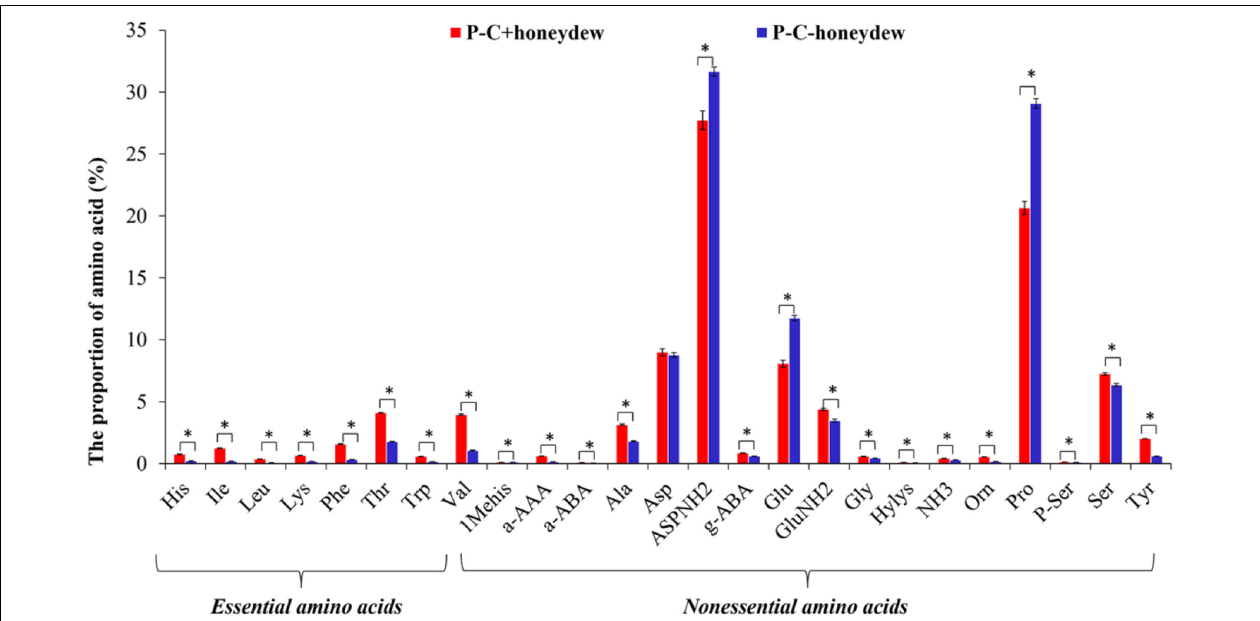
FIGURE 6 | The species of FAAs in honeydew excreted by ACP nymphs feeding on C Las-infected and C Las-free citrus plants. “P+” and “P–” represent C Las positive and negative psyllids, respectively, and “C+” and “C–” represent C Las-infected and C Las-free citrus plants, respectively. Values are represented as mean ± SE, and ∗ over the bars means significant differences between groups at P <